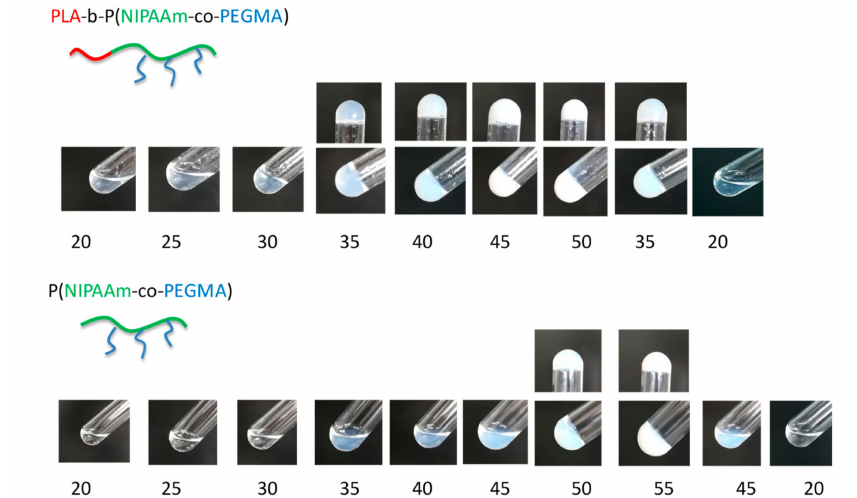
Figure 4. Hydrogel formation vs. temperature (copolymer at 15 wt. % in PBS) through inverted tube